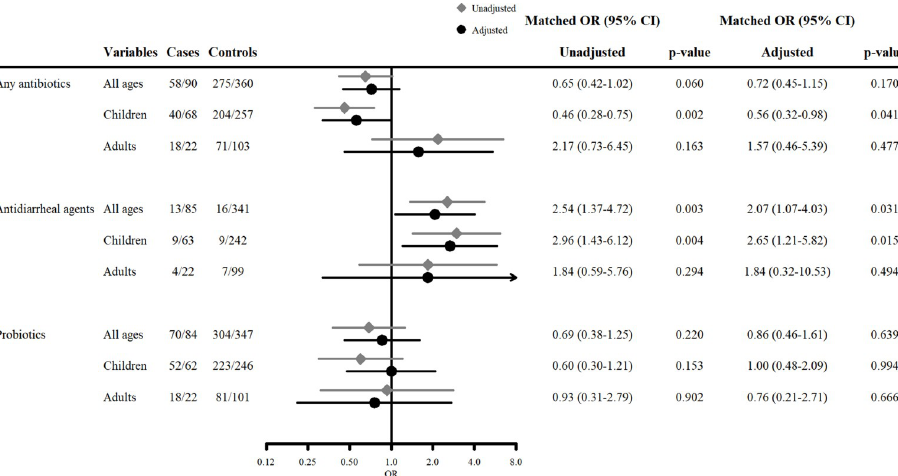
Fig 2. The association between treatment and development of HUS. Unadjusted matched odds ratios were calculated by univariable conditional logistic regression analysis. Adjusted matched odds ratios were calculated by multivariable conditional logistic regression analysis. The following covariates were used for the analyses of any antibiotics: age, sex, area, presence of bloody stool, initial white blood cell (WBC) count, initial CRP level, antidiarrheal agent use, and serotype O157. The following covariates were used for the analyses of antidiarrheal agents: age, sex, area, presence of bloody stool, initial WBC count, initial CRP level, serotype O157, and use of any antibiotics. The following covariates were used in the analysis of probiotics: age, sex, area, presence of bloody stool, initial WBC count, initial CRP level, antidiarrheal agent use, serotype O157, and any antibiotic use.